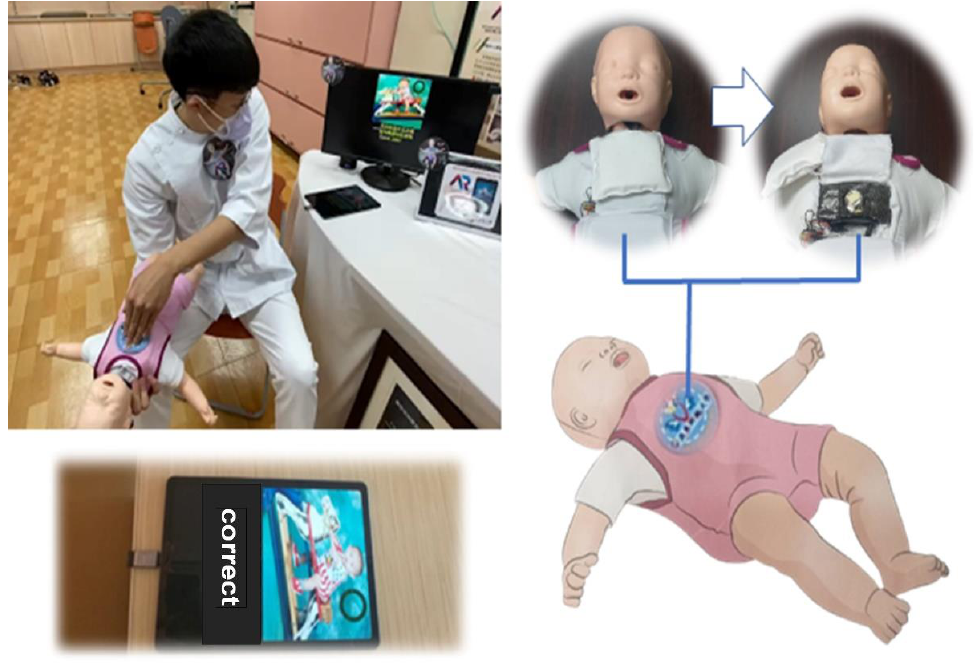
Figure 3. A pressure sensor for detecting chest thrusts.